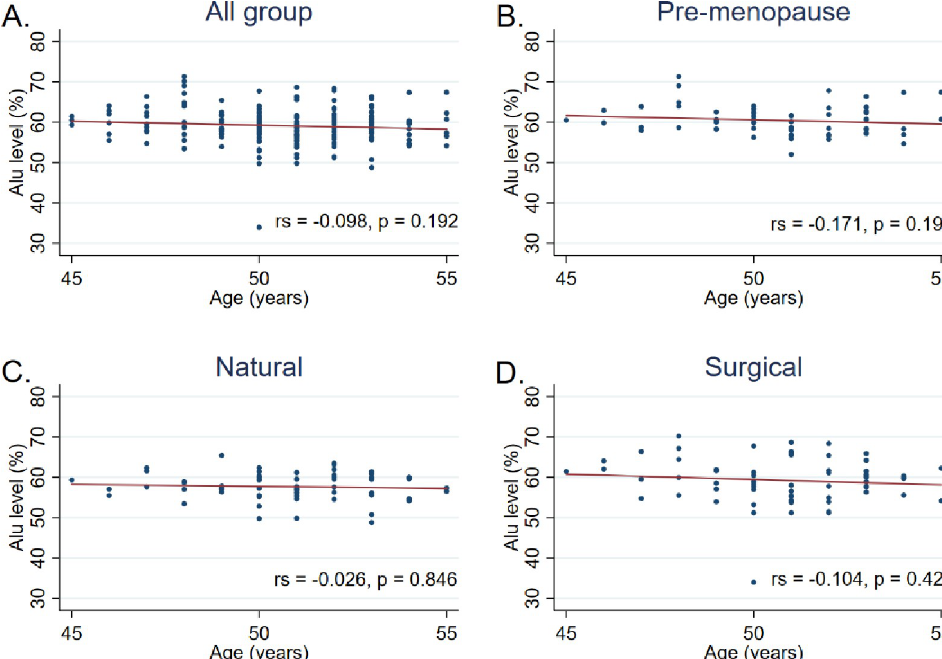
Fig 4. Correlation between the Alu methylation level and age among A) all participants, B) pre-menopause group, C) natural menopause group, and D) surgical menopause group. Data were analyzed using Spearman’s correlation analysis.